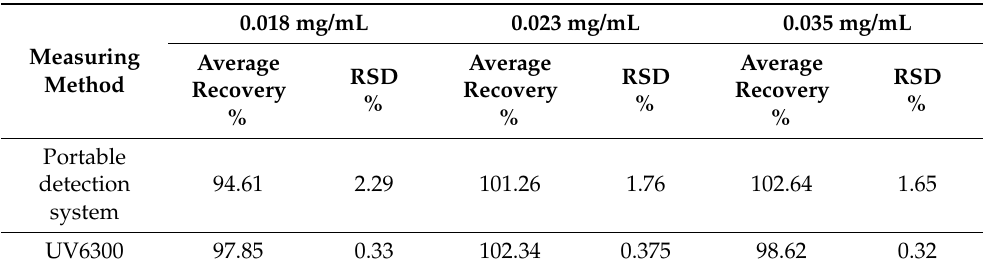
Table 1. Comparison of recoveries and precisions of two methods ( n =